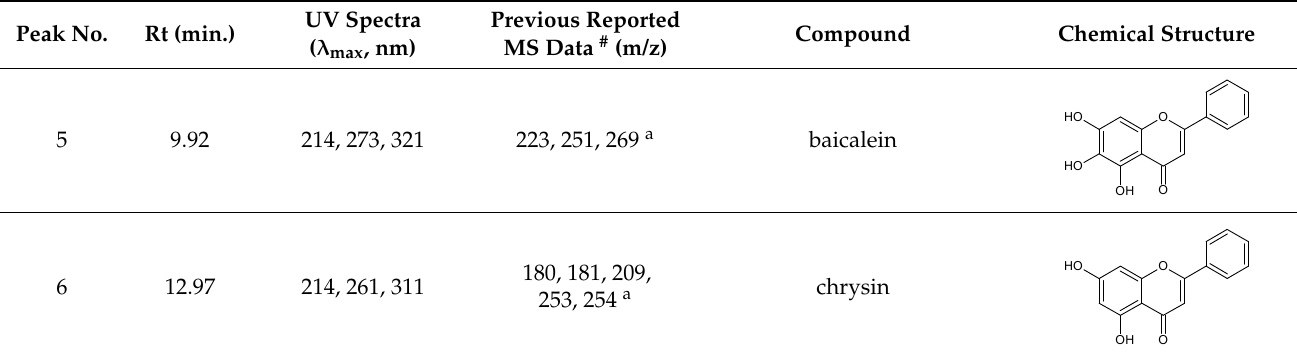
Table 3. Antibacterial Effects Against Clinical Isolated Zoonotic Bacteria of O. indicum Samples.